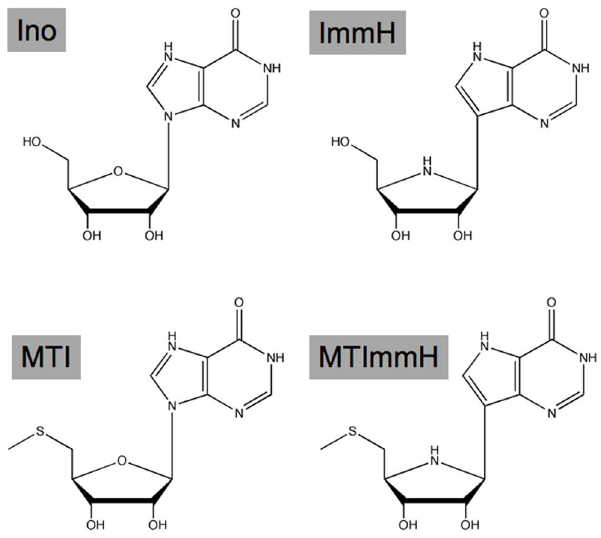
Figure 2. PfPNP substrates and inhibitors. Structures of substrates (inosine and 5 9 -methylthioinosine) and immucillin transition state analogues (ImmH and MT-ImmH) of PfPNP utilized for this study.